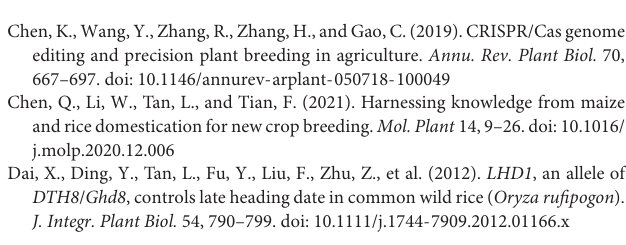
Supplementary Figure 1 | Agronomic traits analysis of CLCWR. (A) The CLCWR plant cultured in soil for 180 days. Bar = 10 cm. (B) The mature seeds of CLCWR. Bar = 1 cm. (C) Agronomic traits of CLCWR. Data are means of three replicates of one experiment. The experiment was repeated three times with similar results. Supplementary Figure 2 | PCR verified of the positive transgenic plants under CLCWR background. The positive transgenic plants of CLCWR transformed with single-genome-editing vector were detected by PCR using Hyg gene primer. M, marker. Supplementary Figure 3 | Genome editing of CLCWR. (A,B) Single genome editing by using CRISPR/Cas9 multiplex genome editing system. OrNCED3 (A) and OrNCED5 (B) were used for single genome editing analysis and produced three types of mutants, respectively. (C) Two-genome editing by using CRISPR/Cas9 multiplex genome editing system. OrNCED1 and OrNCED3 were used for multiplex genome editing analysis and produced two types of mutants. (D–E) Genome-editing efficiency of CLCWR. A total of 20 PCR-positive plants were used for sequencing analysis in each experiment. The sequences of the edited genes of PCR-positive plants were compared by DNAMAN software and analyzed by DSDecode M (http://www.ygliulab.club/dsdecode/). Then, the number of edited plants was counted. The single (D) and multiplex (E) genome editing efficiencies were calculated as the number of mutated plants divided by the number of PCR-positive plants. Supplementary Figure 4 | Amino acid sequence comparison of mutants and WT by DNAMAN software. (A) Amino acid sequence comparison of nced3 mutants and WT. (B) Amino acid sequence comparison of nced5 mutants and WT. Supplementary Figure 5 | Schematic of Agrobacterium -mediated genetic transformation system of CLCWR. Schematic of Agrobacterium -mediated genetic transformation system of CLCWR using scutellum tissue of embryos in the mature seeds. Supplementary Table 1 | Primers used in this study. Supplementary Table 2 | The culture medium used in this